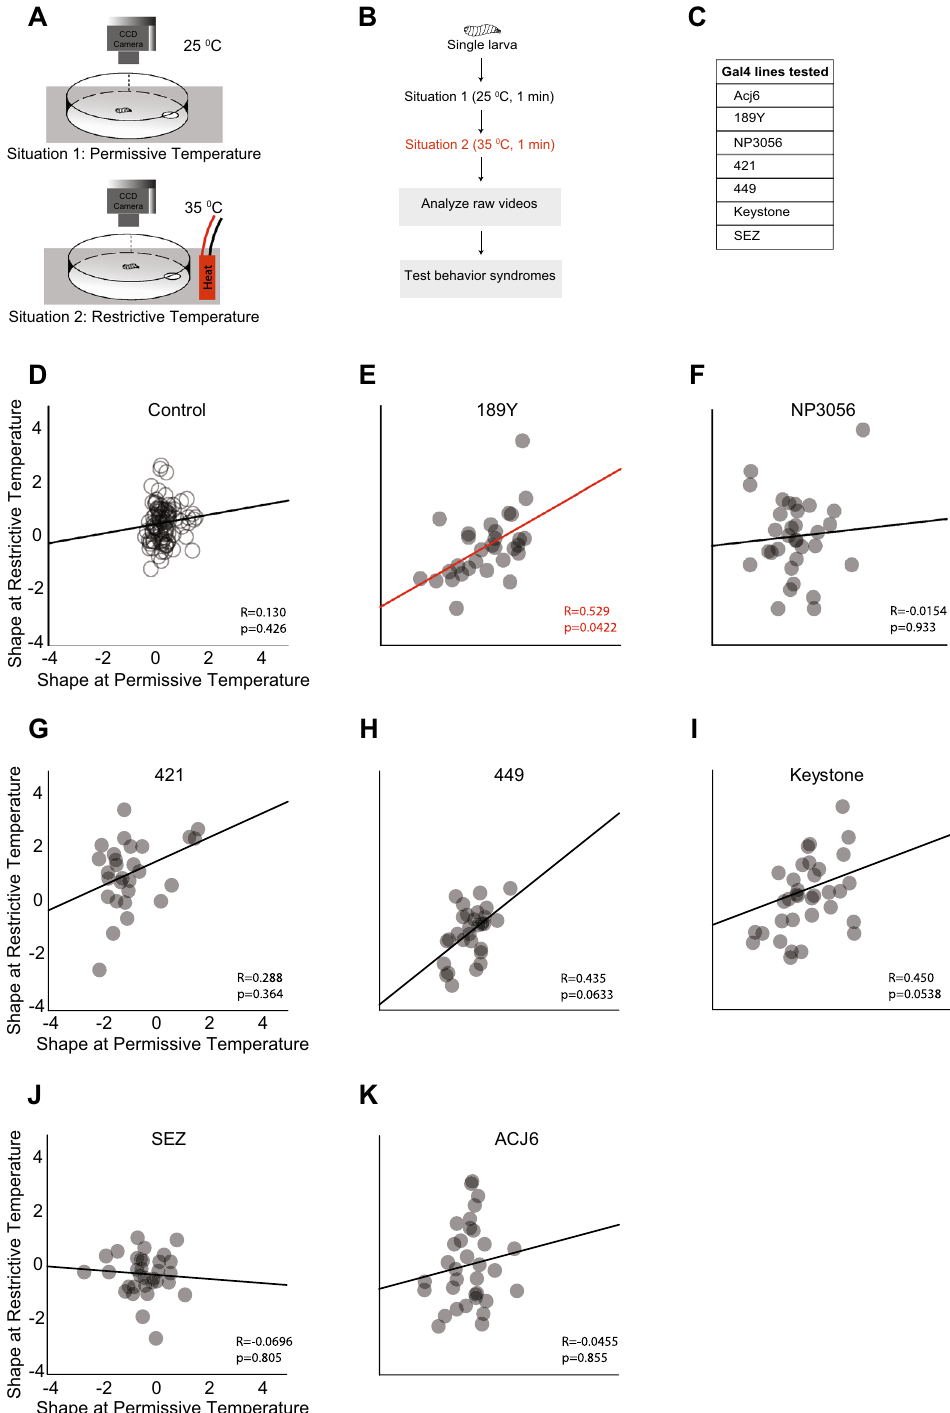
Figure 4. Experiment 4: Influence of antennal lobe neurons on olfactory behavior syndromes. ( A ) A single larva expressing Shi ts in a set of target neurons is allowed to roam freely in a 6-cm Petri dish layered with agarose. Target neurons are inactivated by raising the temperature of the arena to 35 °C. Larval movements are recorded under situation 1 (25 °C) and situation 2 (35 °C). The assay is repeated for ~ 90 larvae in the parental control line and ~ 30 larvae for each experimental line. ( B ) A schematic of the paradigm and ( C ) a list of seven Gal4s used to target specific sets of downstream neurons are provided on the right. ( D–K ) Correlations between the shape of larval movement in situation 1 (permissive temperature, 25 °C) and restrictive temperature, 35 °C) are shown ( D ) control larvae, p = 0.426, n = 93 and larvae in which sets of neurons targeted by the following Gal4 lines are inactivated: ( E ) 189Y, p = 0.0422, n = 30; ( F ) NP3056, p = 0.933, n = 32; ( G ) 421, p = 0.364, n = 28; ( H ) 449, p = 0.0633, n = 30; ( I ) Keystone, p = 0.0538, n = 35; ( J ) SEZ, p = 0.805, n = 32; ( K ) Acj6, p = 0.855, n =